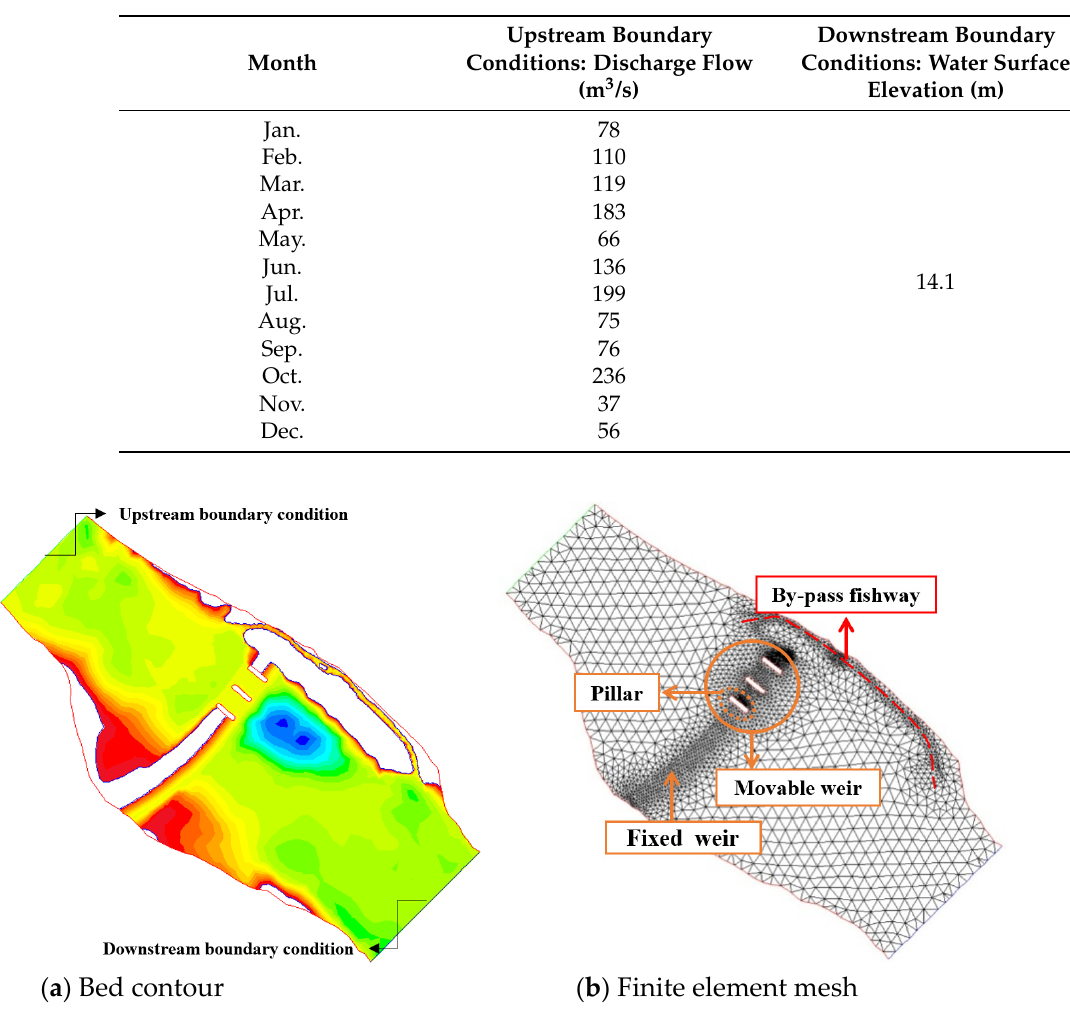
Table 1. Simulation condition of River2D model.